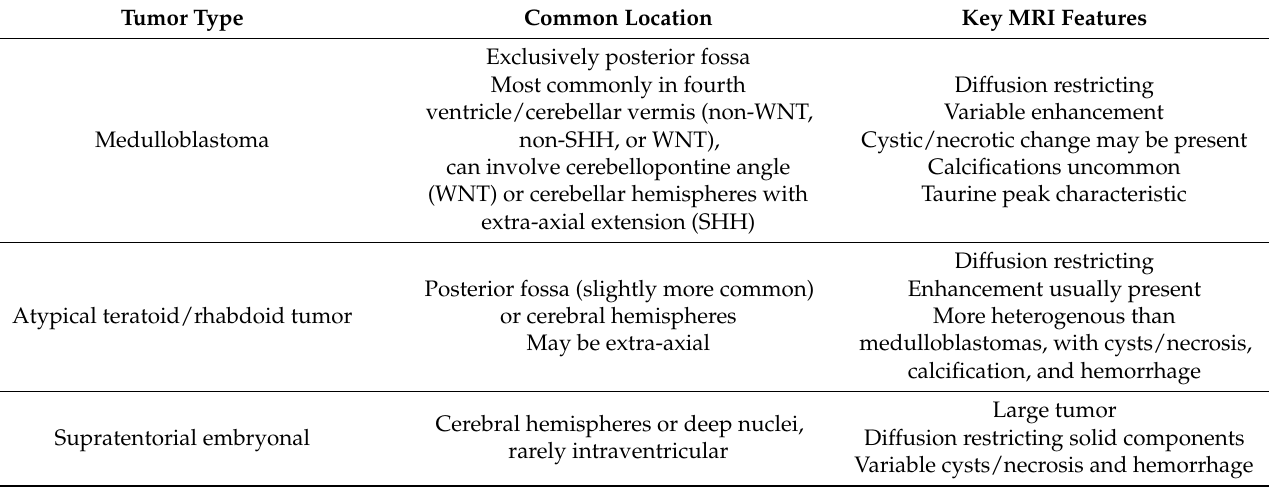
Table 1. Summary of key imaging features of embryonal